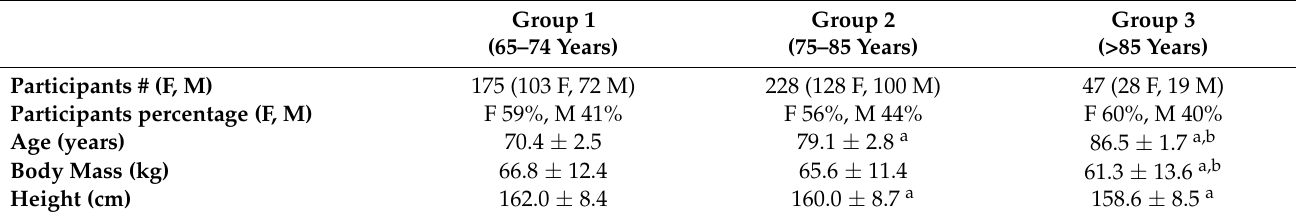
Table 1. Participant’s characteristics. Values are expressed as mean ± SD.